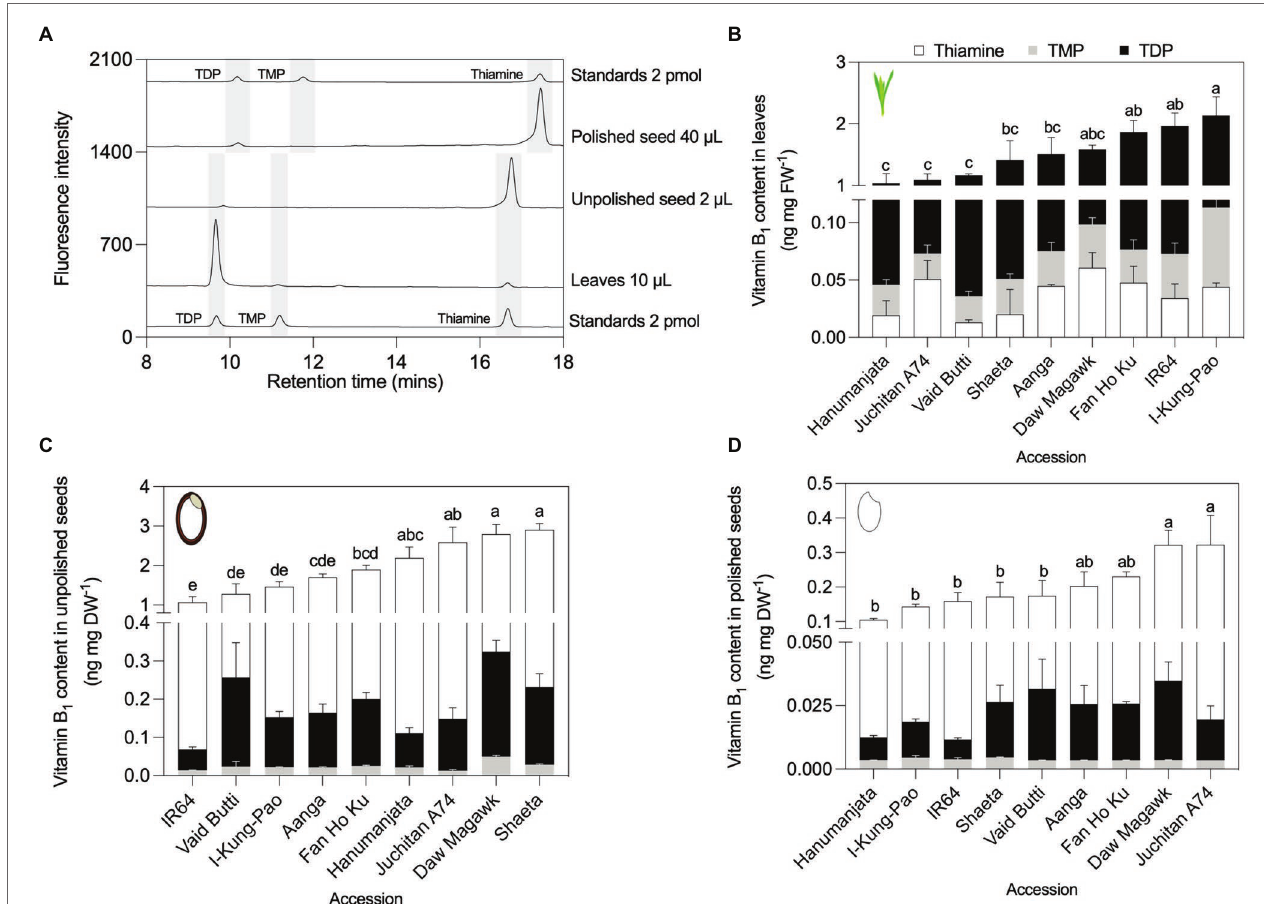
FIGURE 4 | HPLC profiling of B 1 vitamers in leaves and seeds of rice accessions contrasting in total vitamin B 1 contents. (A) Representative HPLC chromatograms of leaf and seed tissues. To facilitate visualization, chromatograms were offset from the baseline by 50 units for standards at bottom of the panel, 350 units for leaves, 950 units for unpolished seeds, 1,400 units for polished seeds, and 1,900 units for standards used for quantification of polished seed samples. Shifts in retention time can occur as a result of slight changes to the pH of HPLC running buffers between experiments. HPLC analysis of B 1 vitamers in leaves (B) , unpolished seeds (C) , and polished seeds (D) . Samples were obtained from plant material grown under greenhouse conditions in experiment 2. Leaves were sampled from 40-day-old plants. Seed samples were obtained from fully mature pannicles and dried before extraction. Data are the mean ± standard deviation of n = 3 biological replicates. The effect of accession on total vitamin B 1 contents in panels (B–D) was determined by one-way ANOVA ( α = 0.05) with multiple comparisons and Tukey’s post-hoc test. Statistically significant differences between accessions are denoted by different